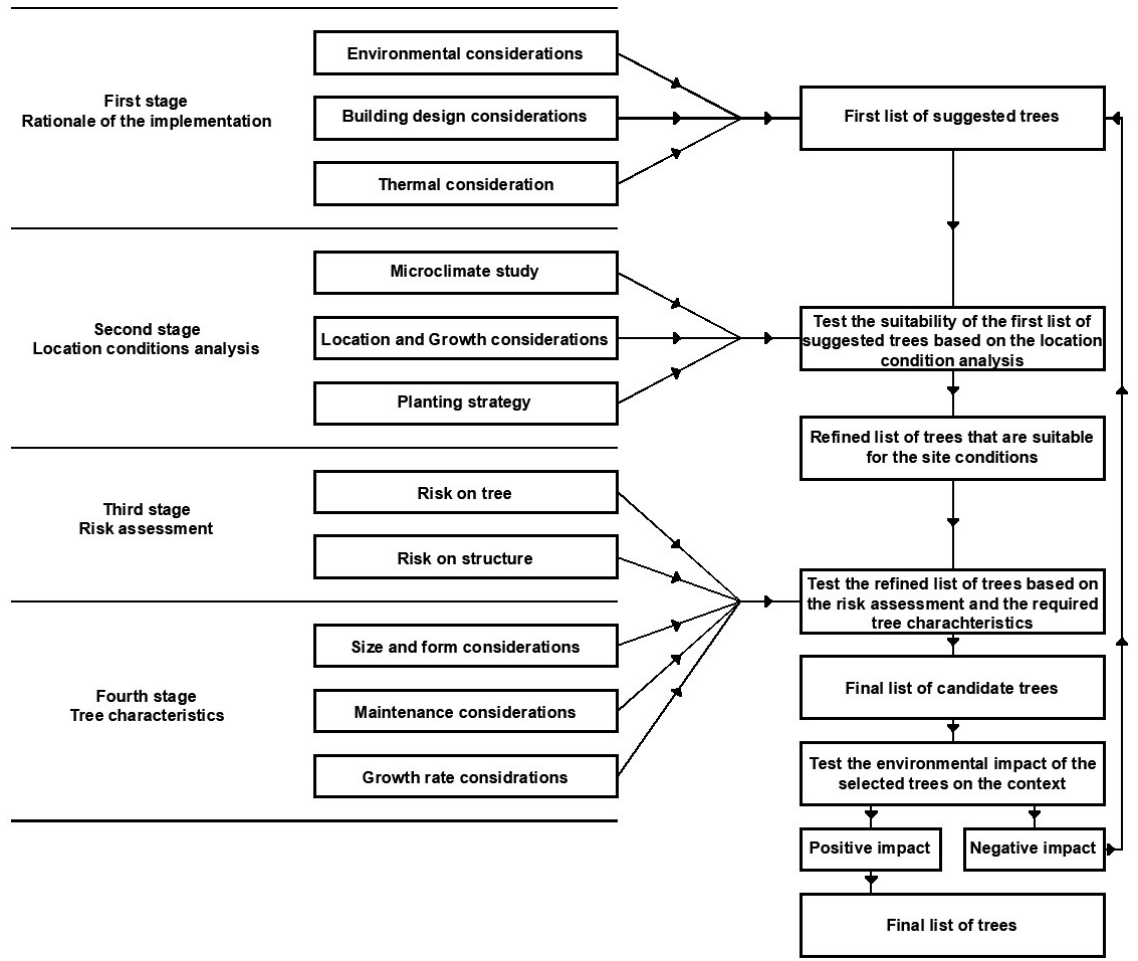
Figure 5. Proposed tree selection framework for implementation on buildings.